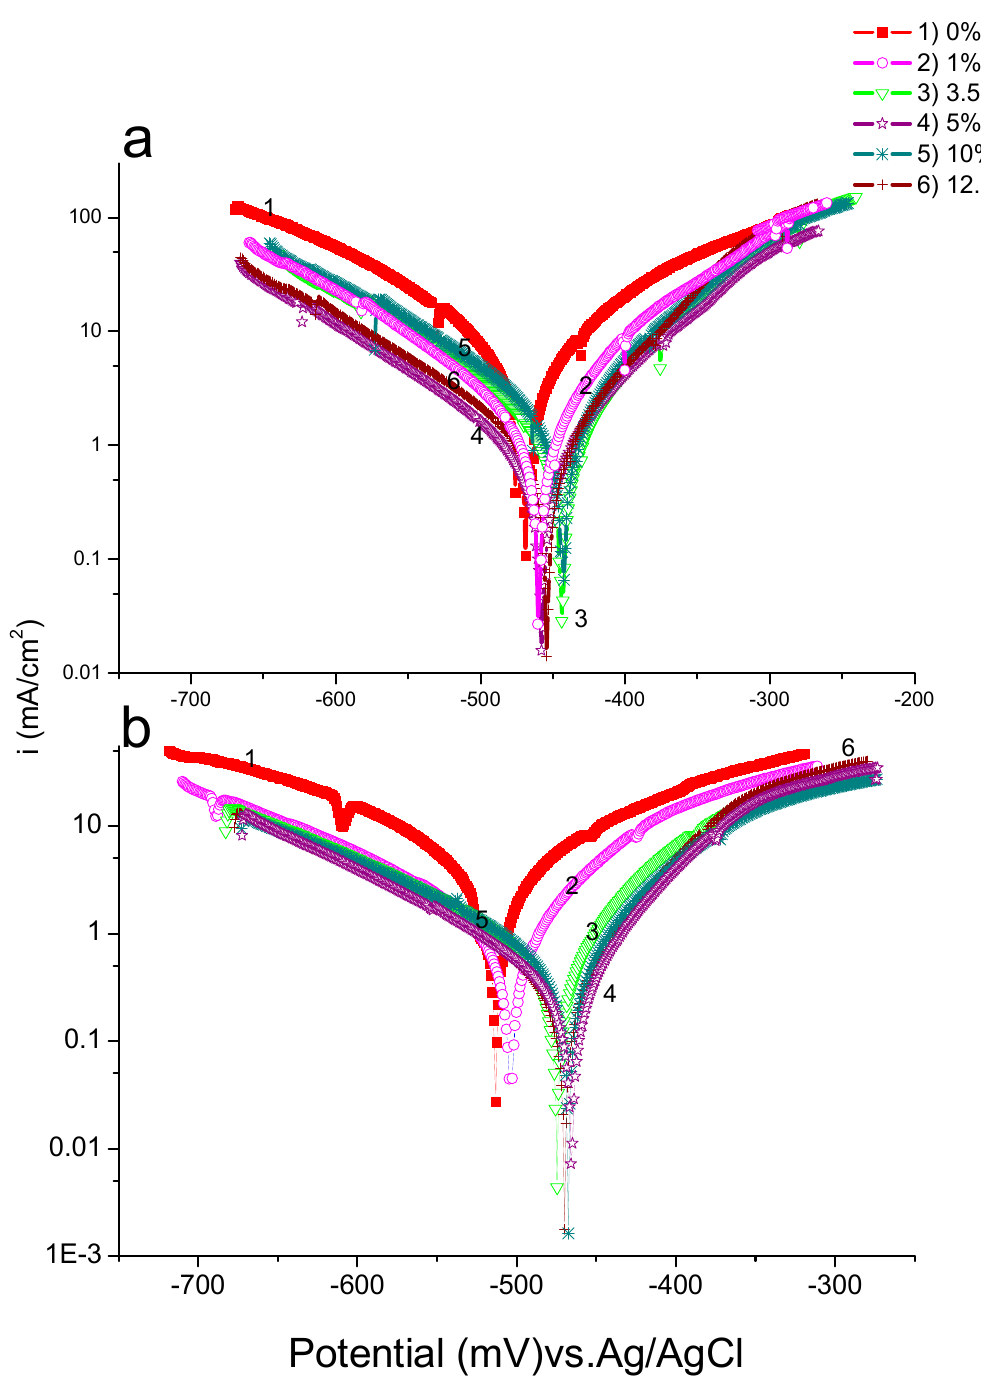
Figure 3. Potentiodynamic polarization curves for Carbon steel in ( a ) 2 M H 2 SO 4 and ( b ) 2 M H 3 PO 4 in the absence and presence of different concentrations of ASMS at 298 °K.